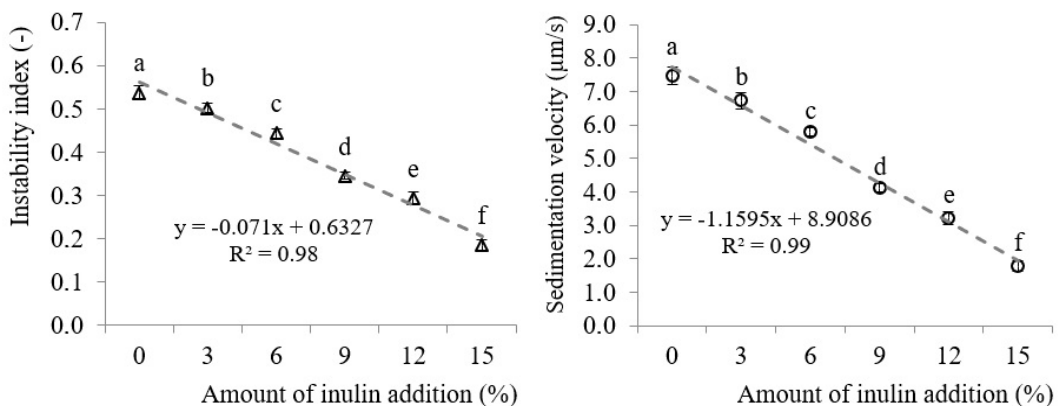
Figure 9. Instability indexes and sedimentation velocity of particles values (position in 120–130 mm) of yogurts with 0%, 3%, 6%, 9%, 12% or 15% w/w inulin addition measured using CSA method—LUMiSizer test (a, b, c…—various letters for average values mean statistically significant differences, p < 0.05).